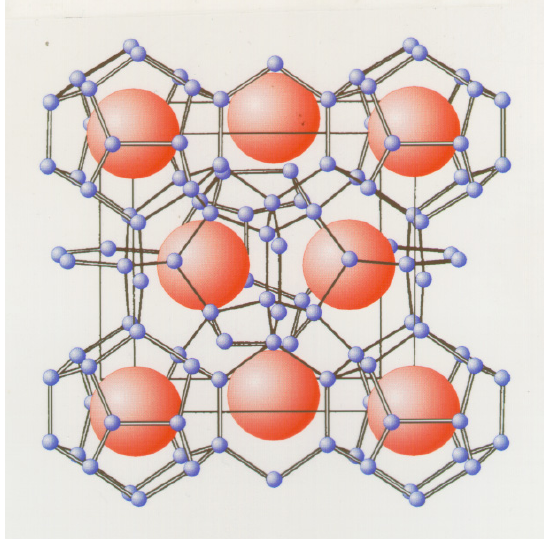
Figure 1. Smallest symmetrical unit cell for hydrate structure I is cubic with side lengths12.01 Å at zero Celsius, and smaller for lower temperatures [5,6]. Red spheres illustrate a simplified monoatomic model for methane. Water molecules are scaled down and plotted in Cyan color. Black lines are average hydrogen bonds. The figure was plotted by Geir Huseby (Huseby, G., “ Kinetiske hydratinhibitorer ”, MSc Thesis, Høgskolen i Telemark, Norway, 1995) based on coordinates from Bjørn Kvamme as used in molecular dynamics simulations.